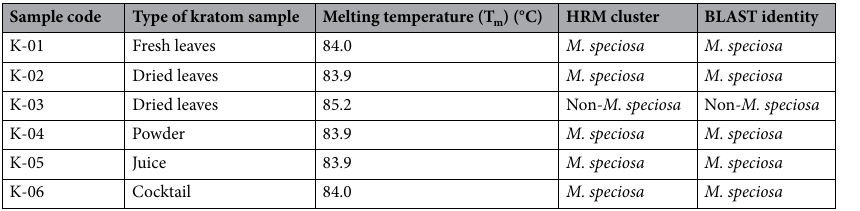
Table 4. Investigation of suspected kratom samples using HRM clustering and query matching of ITS2 sequences in the NCBI database.